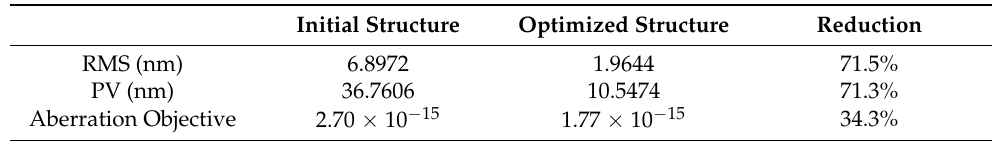
Table 2. Performance comparison between the optimized and initial structure of the primary mirror in the horizontal optical axis.